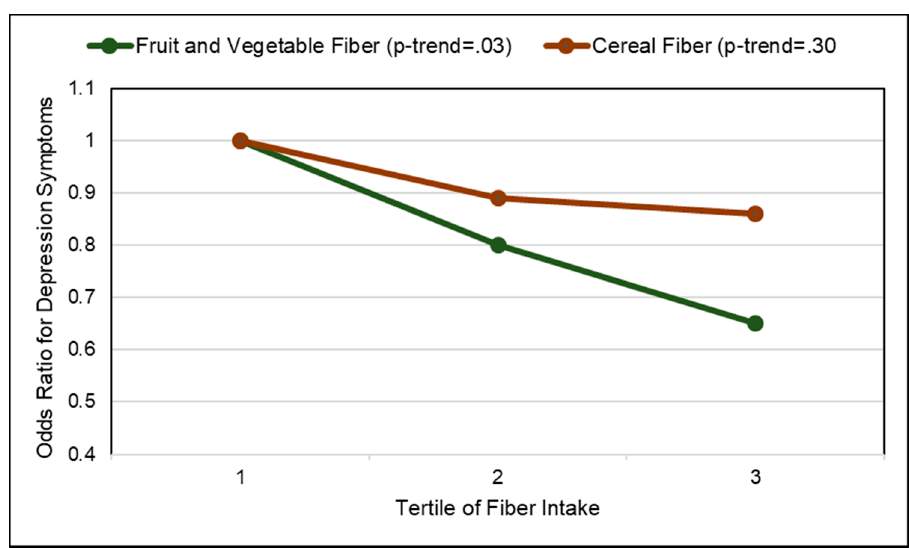
Figure 23. Odds ratio for depressive symptoms with fruit and vegetable fiber intake compared to cereal fiber (fruit and vegetable fiber tertiles = 1.5 g, 2.5 g and 4.0 g) [336].